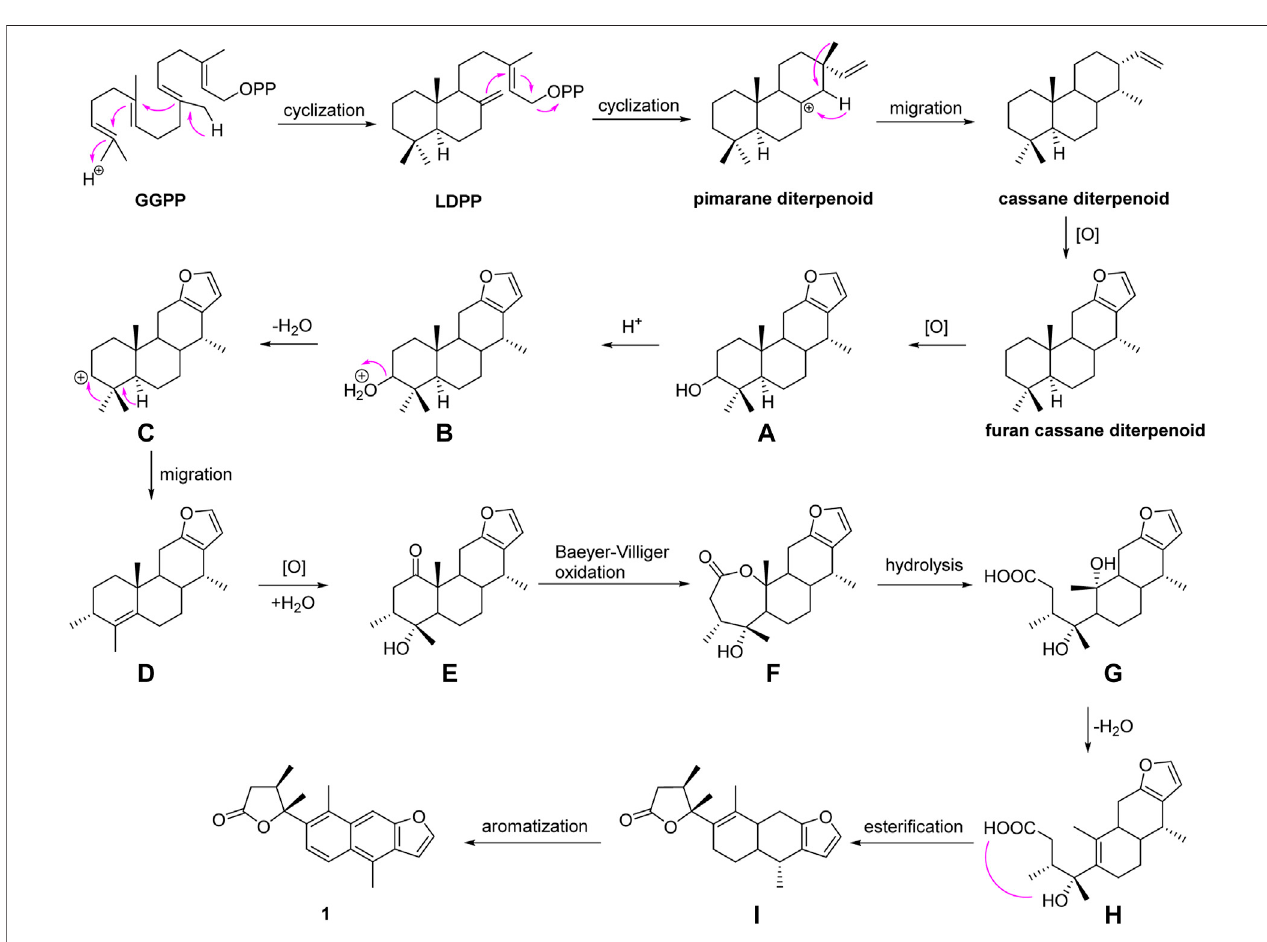
SCHEME 1 | Plausible biosynthetic pathway for 1 .